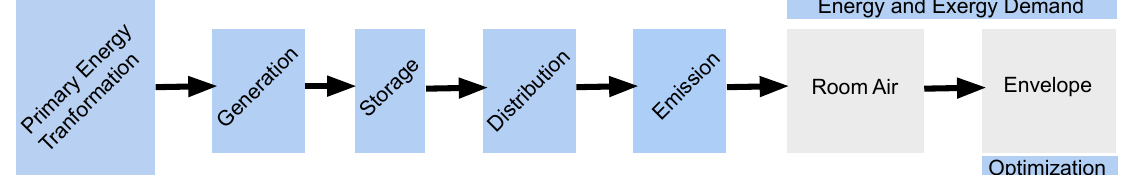
Figure 1. Energy supply chain for space climatization in